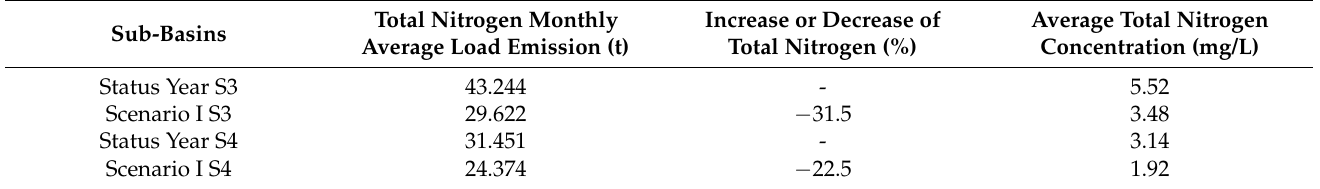
Table 6. Pollution changes in key source areas under reduced fertilization